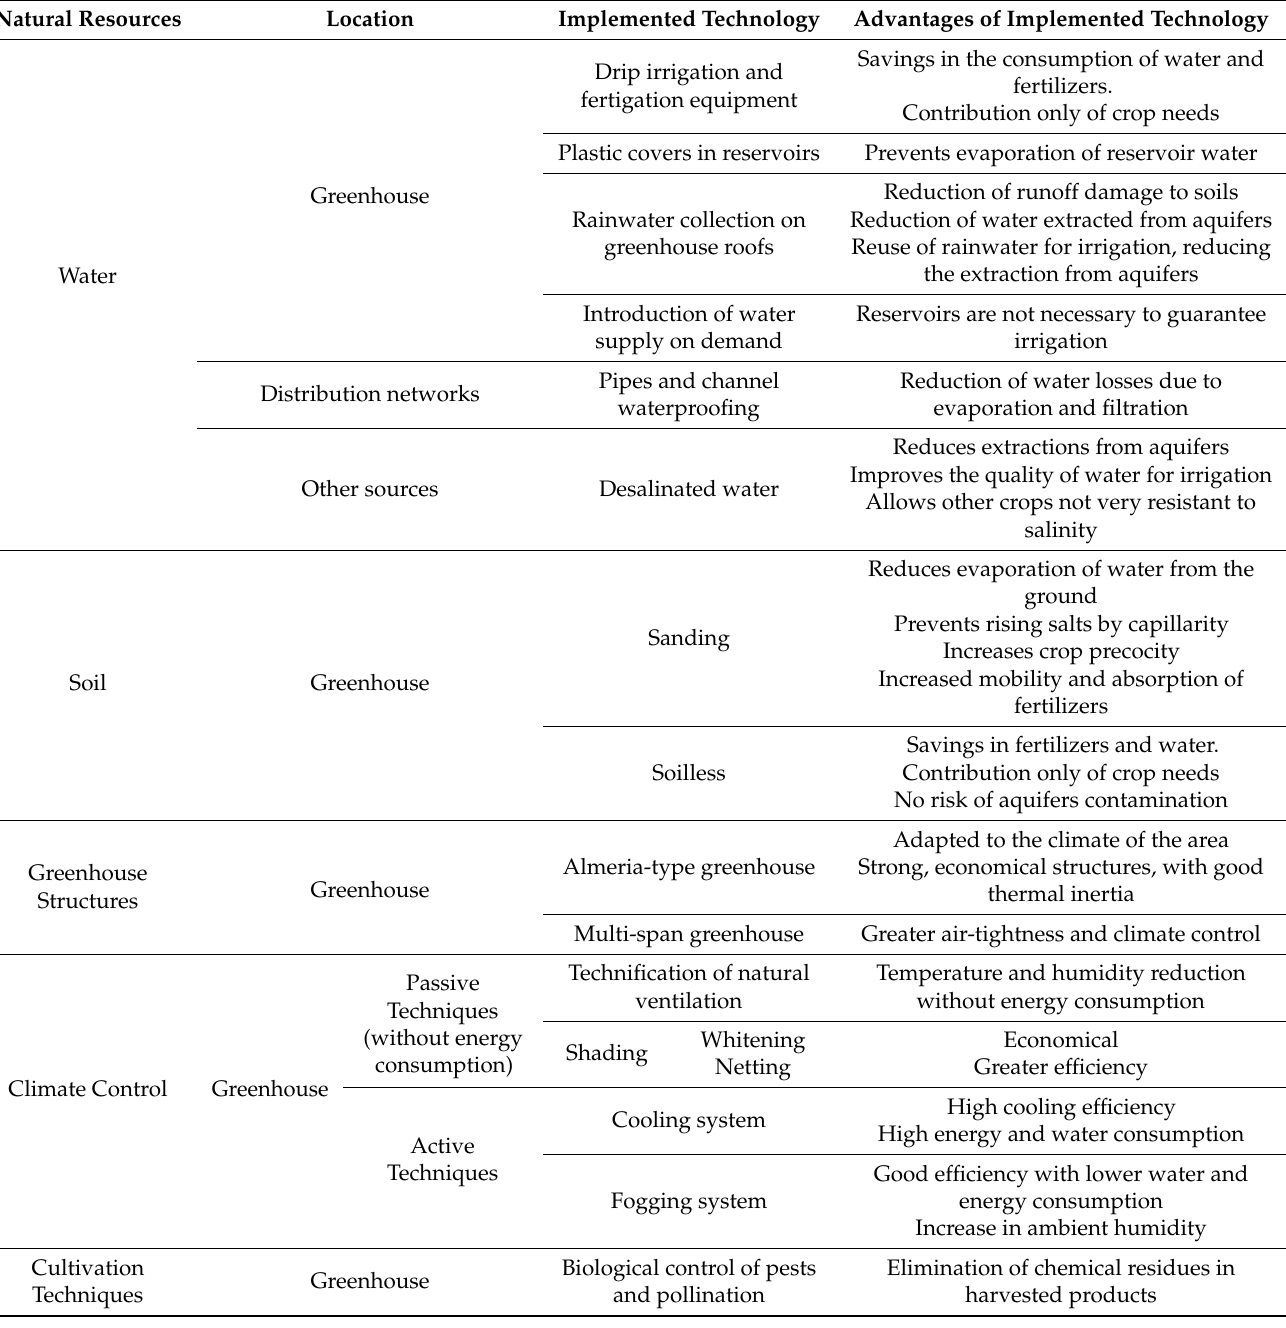
Table 1. Greenhouse technology with repercussions on the